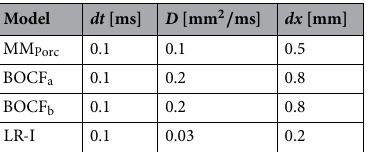
Table 3. This table lists the time step dt , the spatial grid parameter dx and the diffusion constant D for all investigated cell models.